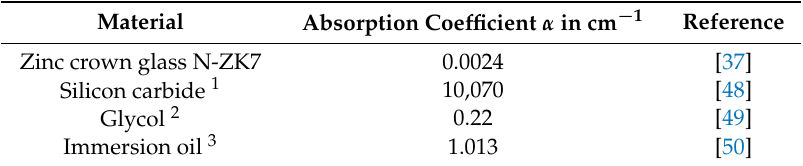
Table 1. Absorption coefficients of the investigated zinc crown glass, silicon carbide, glycol, and immersion oil at a wavelength of λ = 1030